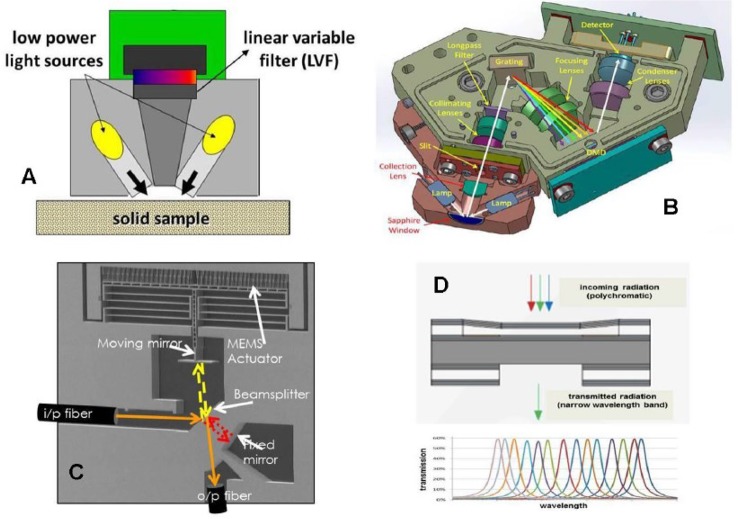
The optical schemes of hand-held NIR spectrometers based on different monochromator principles (A) VIAVI MicroNIR 1700, linear variable filter; (B) DLP NIRscan Nano EVM with Texas Instruments´ digital micromirror device (DMD™); (C) Si-Ware Systems, MEMS-based FT-NIR spectrometer; (D) Spectral Engines NIR spectrometer with tunable Fabry-Perot interferometer.